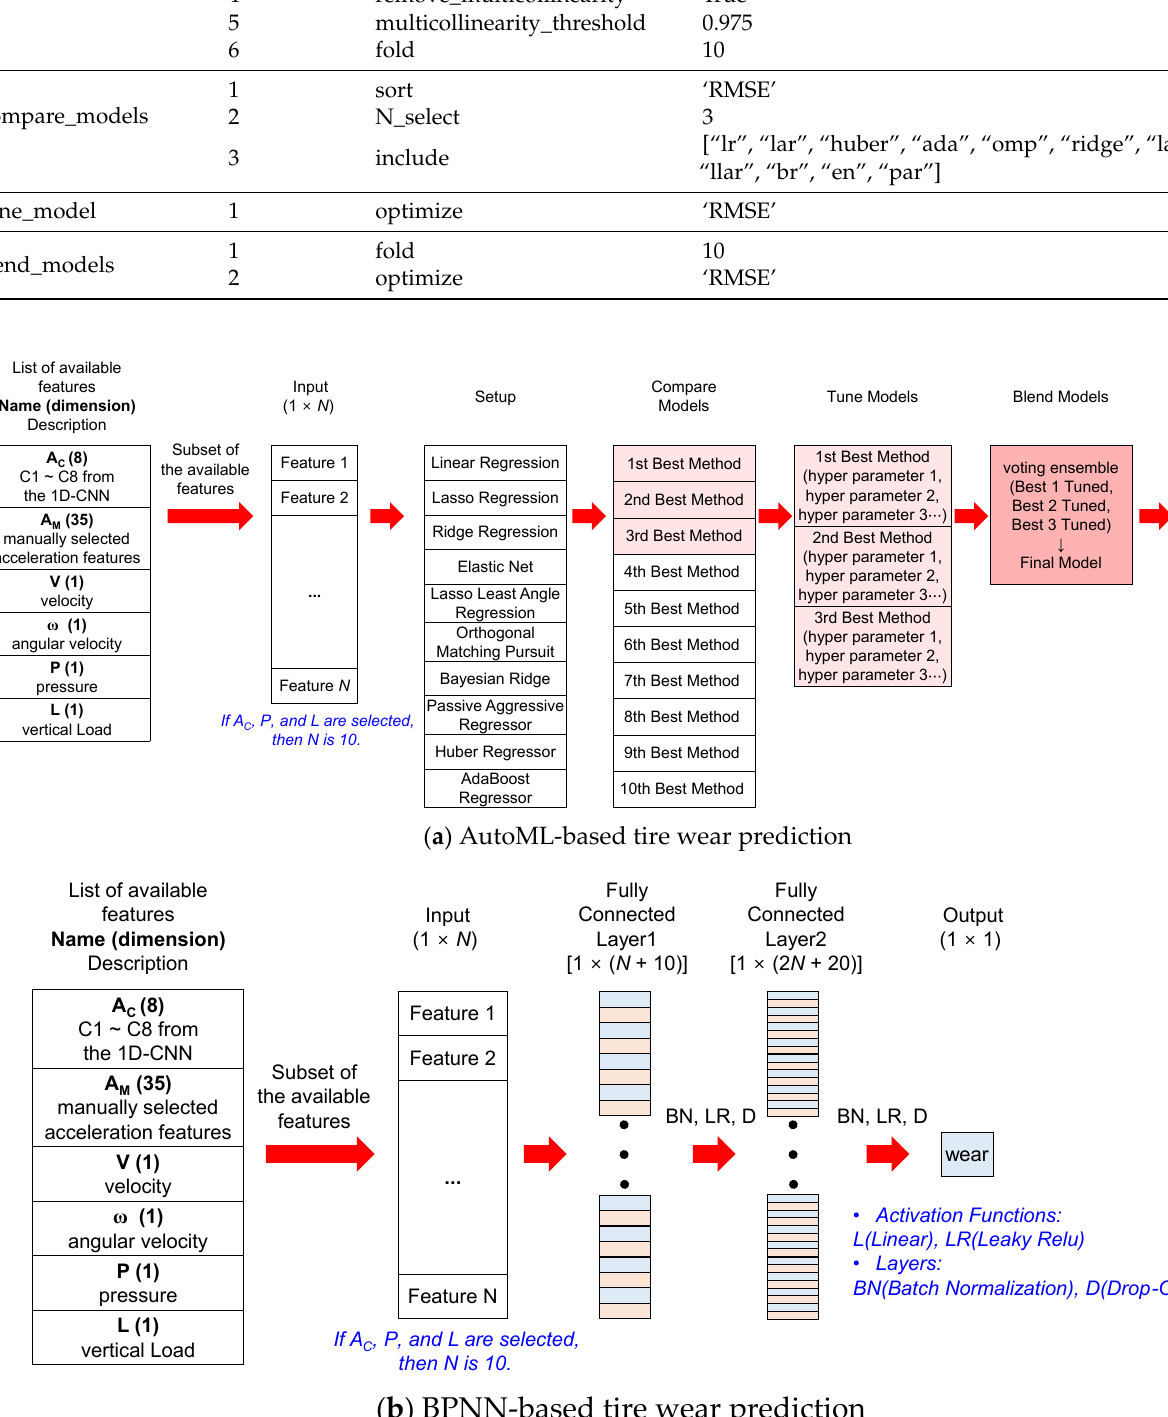
Figure 10. Schematic of the tire wear prediction. Table 4. Hyper parameters of the BPNN for tire wear prediction.